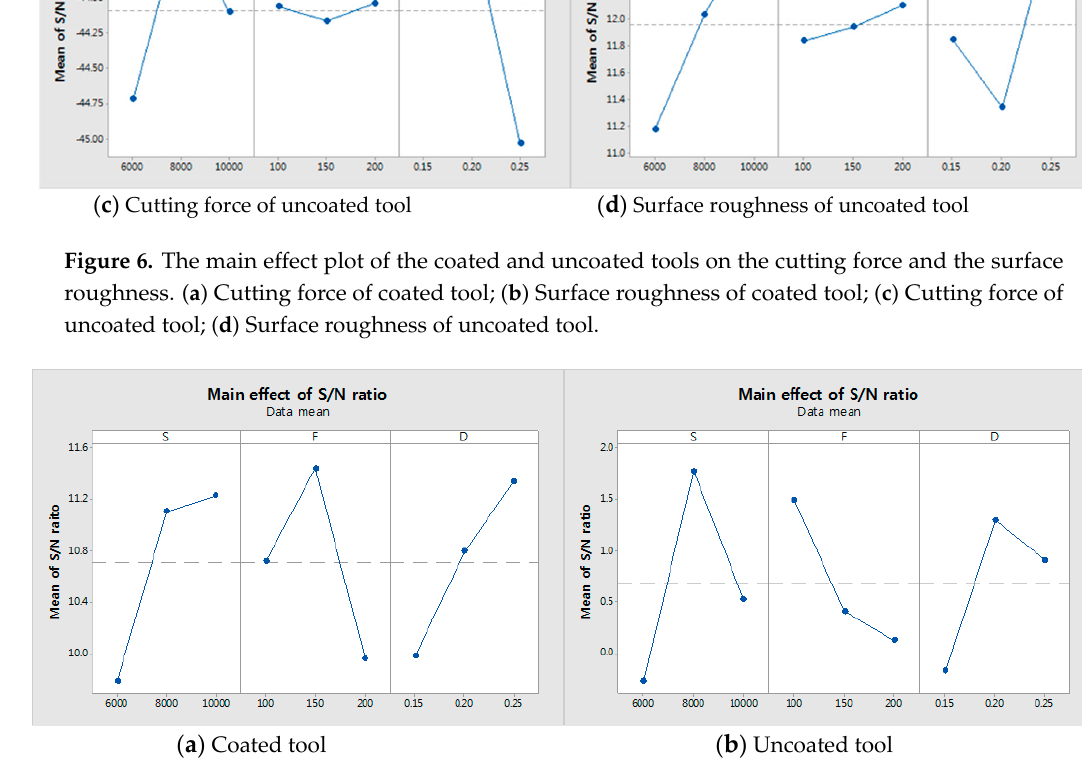
Figure 7. The main effect plot of the coated tool and uncoated tool on the tool wear. ( a ) Coated tool; ( b ) Uncoated tool.